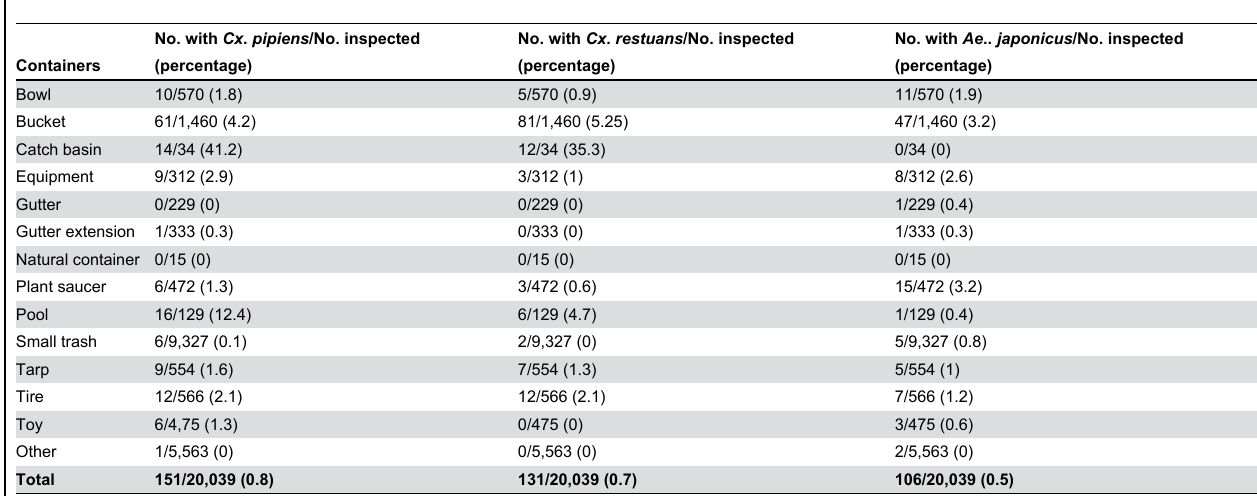
Table 3. Occurrence of other mosquito species that exploit containers during immature stages in urban northeastern US.